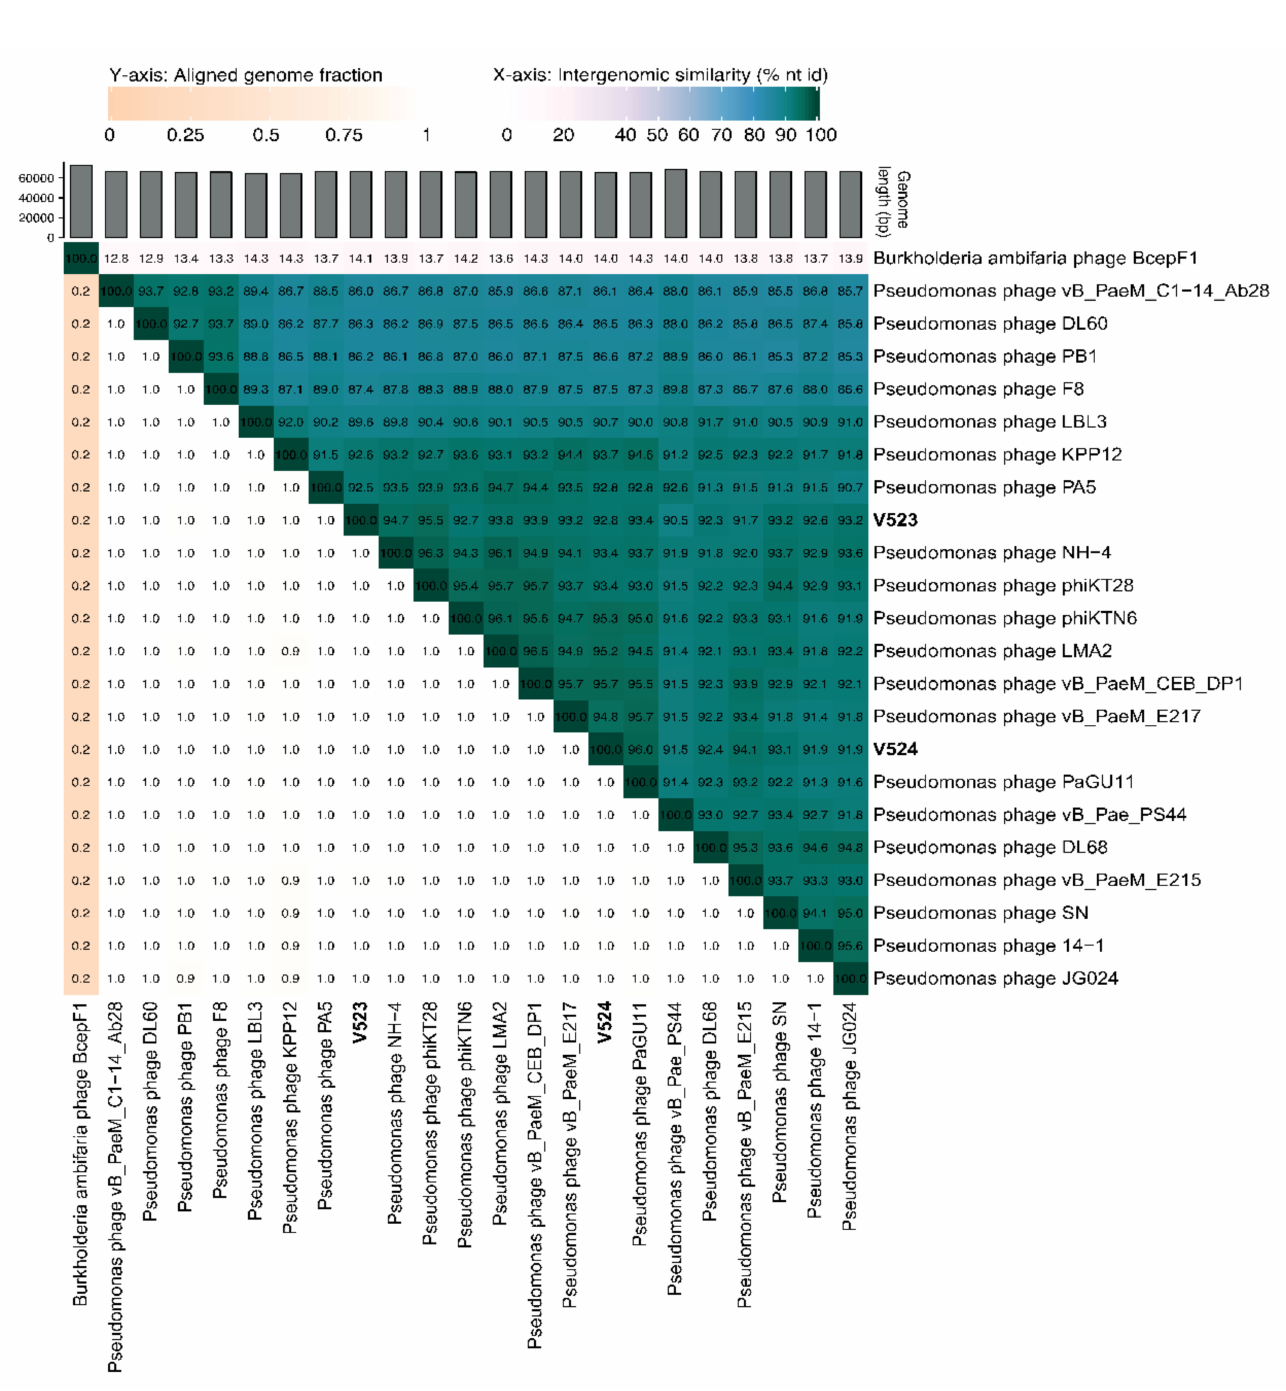
Figure 4. A heat map displaying the similarity between V523 and V524 to reference genomes within the Pbunavirus genus and closely related published Pbunavirus phage, created using VIRIDIC [39]. Accession numbers for previous phage isolates can be found in Supplementary Table